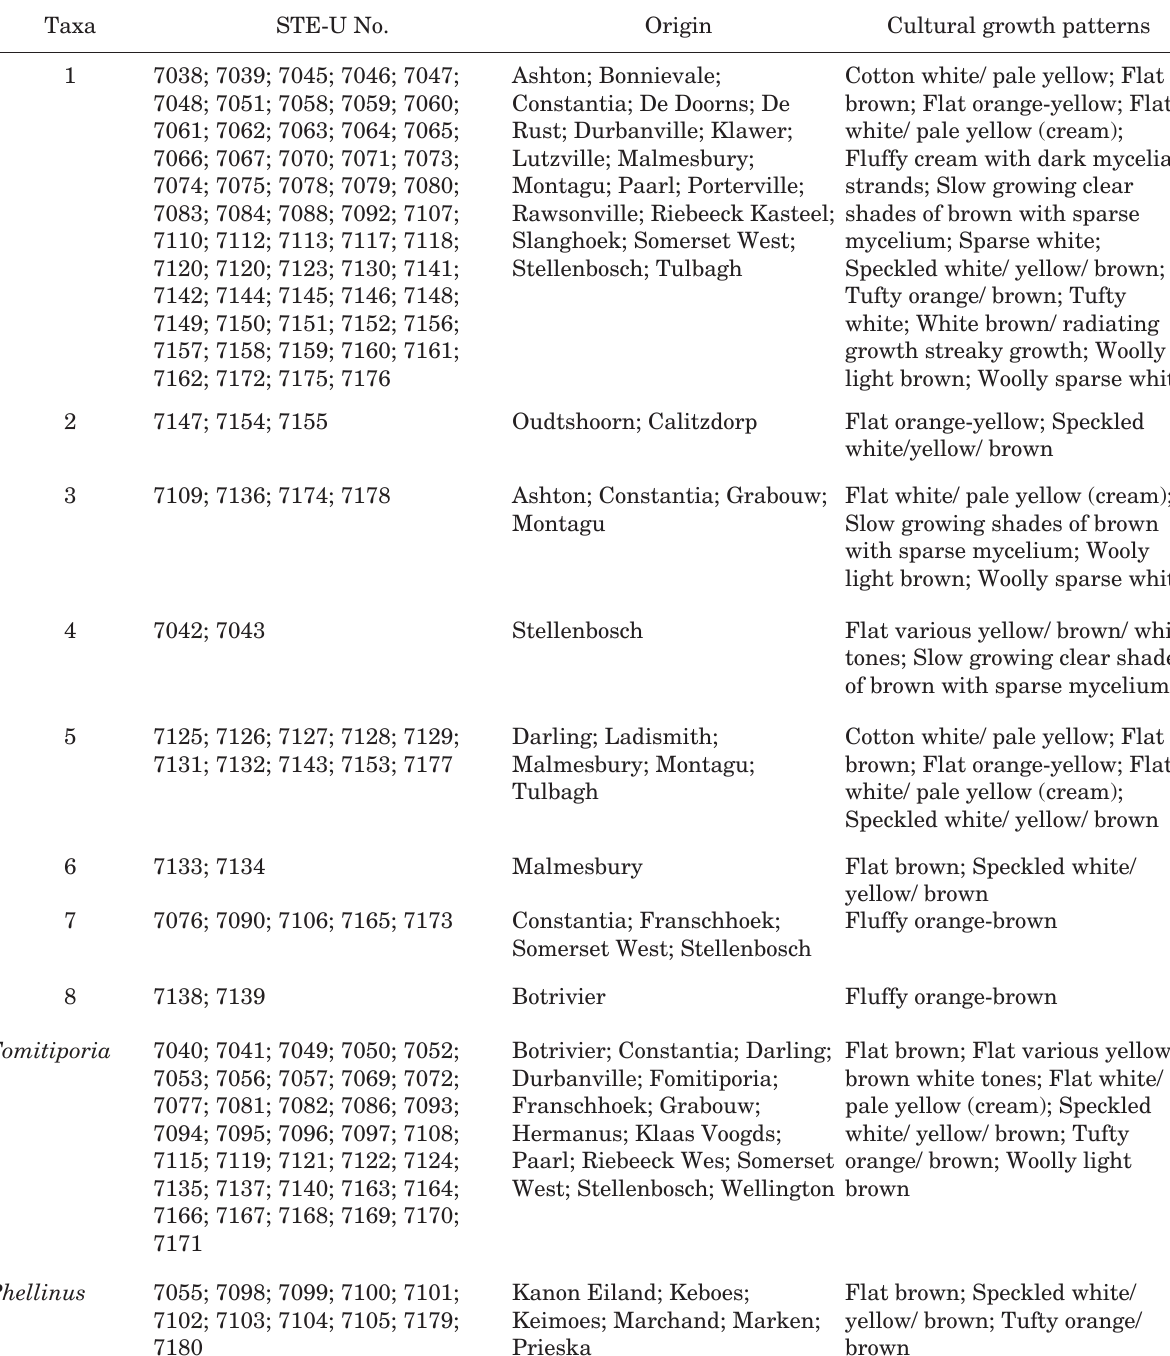
Table 3. Description of the cultural growth patterns of the basidiomycete isolates after 4 weeks on PDA.